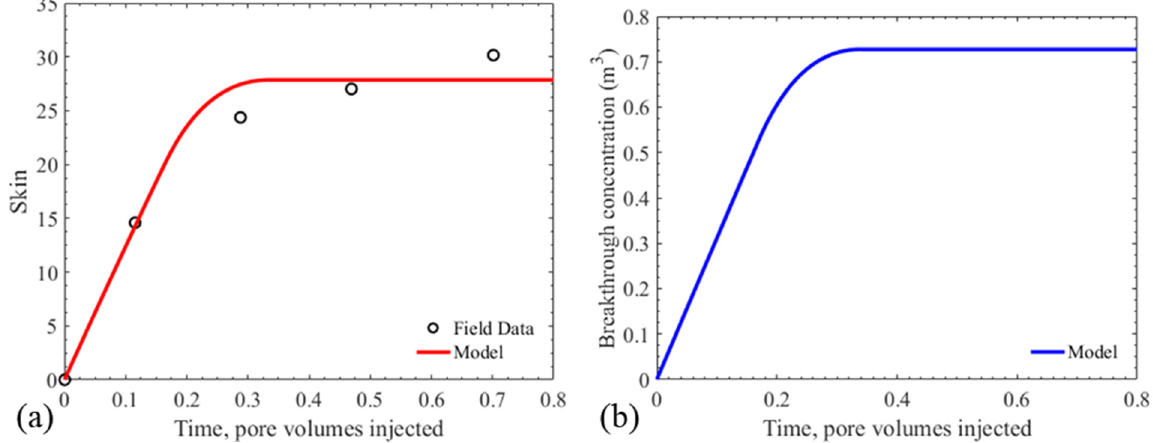
Figure 12. Results of tuning three model coefficients (filtration and formation damage coefficients, and drift delay factor) for a well during the later stages of skin growth (Case 7 from Davidson, Franco, Gonzalez and Robinson [47]), ( a ) skin vs. PVI, ( b ) the cumulative fines production at the wellbore vs. PVI.